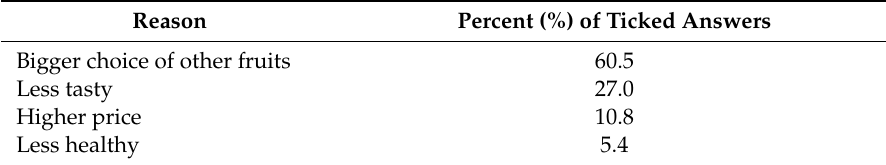
Table 3. Reasons given by declining apple consumers for their lower